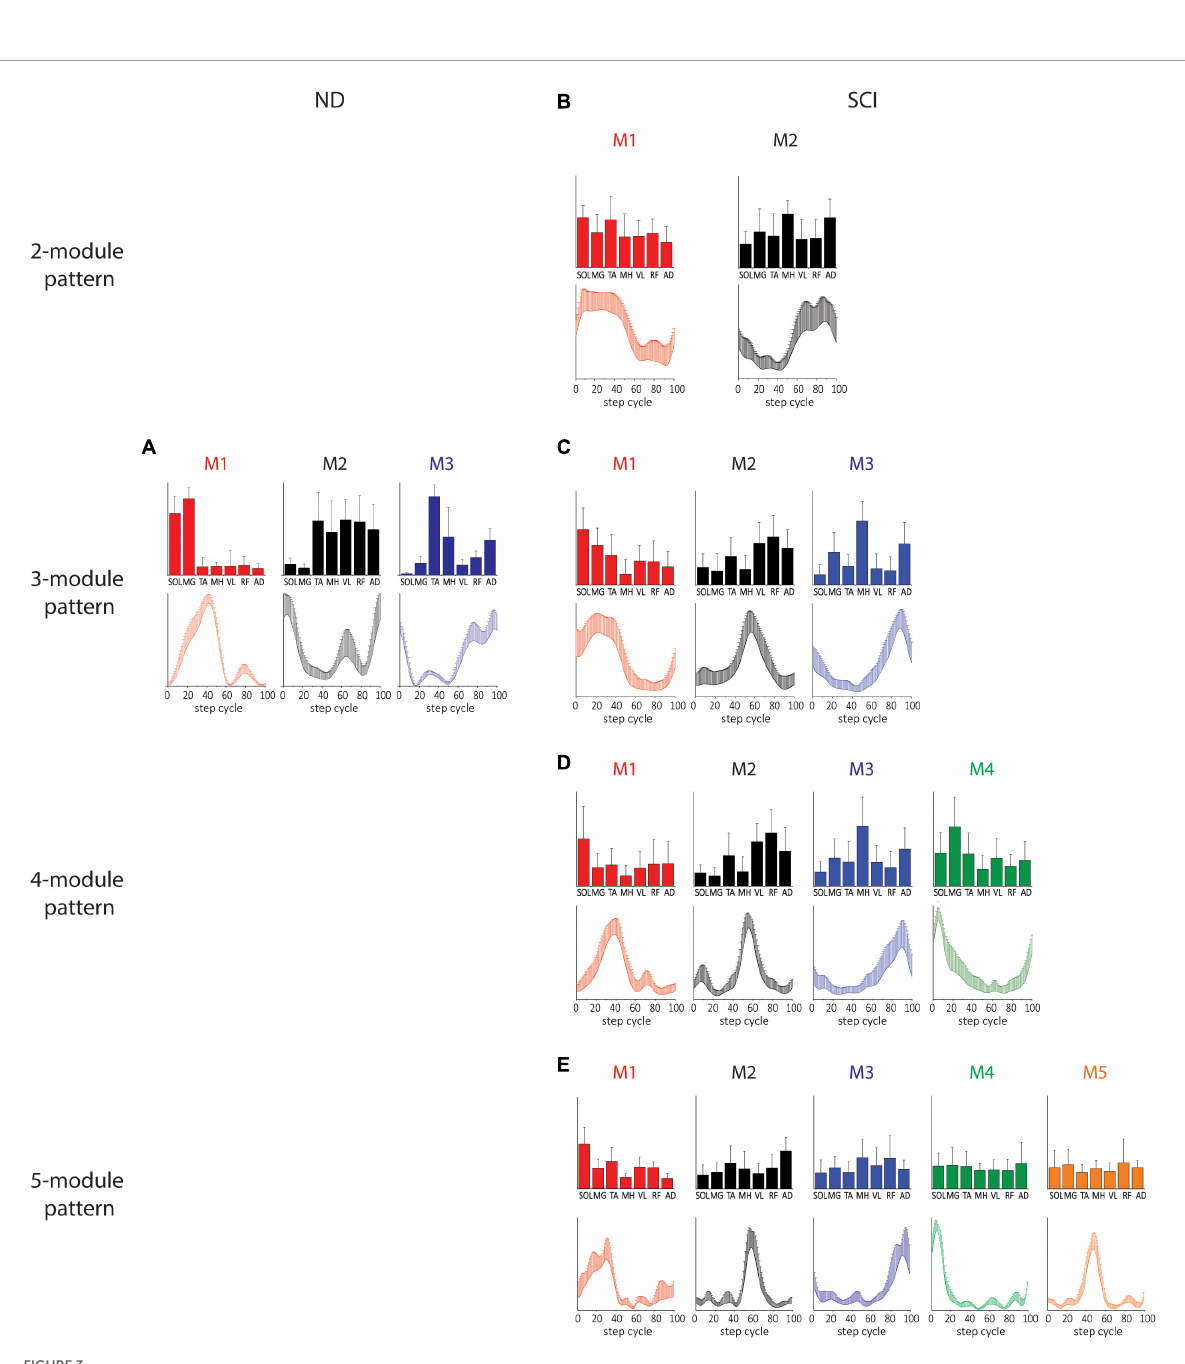
FIGURE3 Spatial and temporal patterns identified by TF-NMF in NDs and SCIs. (A) ND 3-module pattern. (B–E) SCI 2-, 3-, 4-, and 5-module patterns. The correlations between the ND and SCI ND 3-module patterns were: for M1, temporal pattern r = 0.79 and spatial pattern r = 0.82; for M2, temporal pattern r = –0.30 and spatial pattern r = 0.75; for M3, temporal pattern r = 0.83 and spatial pattern r =